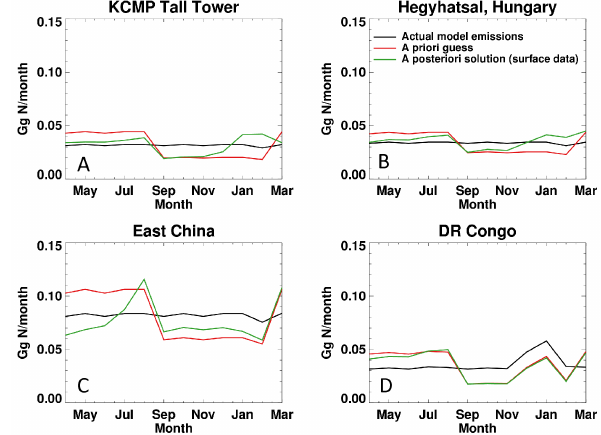
Figure 8. Resolving seasonal emission biases. The panels show the results from an OSSE in which a seasonally dependent a priori emis- sion bias is applied and we test the ability of the inversion to recover the true model fluxes. Results are shown for a site with continuous observations (KCMP tall tower), a site with ∼ weekly flask obser- vations (Hegyhátsál, Hungary), a site with routine flask measure- ments ∼ 1000km downwind (East China), and a remote site in the Democratic Republic of Congo (DR Congo). The a priori (red), a posteriori (green), and true model fluxes (black) are plotted for the first year of the simulation (April 2010–March 2011), with the a priori guess for soil emissions biased high in the first half of the in- version period (1.5 × ; March–August) and biased low in the second half (0.5 × ;